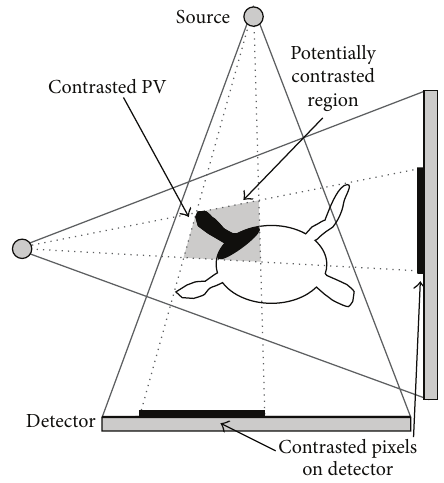
Figure 6: Top-down view on a left atrium with a contrasted pulmonary vein. The gray region denotes the area which may contain contrast agent based on the contrast agent observed in the 2D images. If the number of contrasted voxels in the volume was to be optimized, the optimization process would find a transformation suchthatasmuchofthepotentiallycontrastedregionaspossiblewas included within the LA causing a registration bias towards larger LA